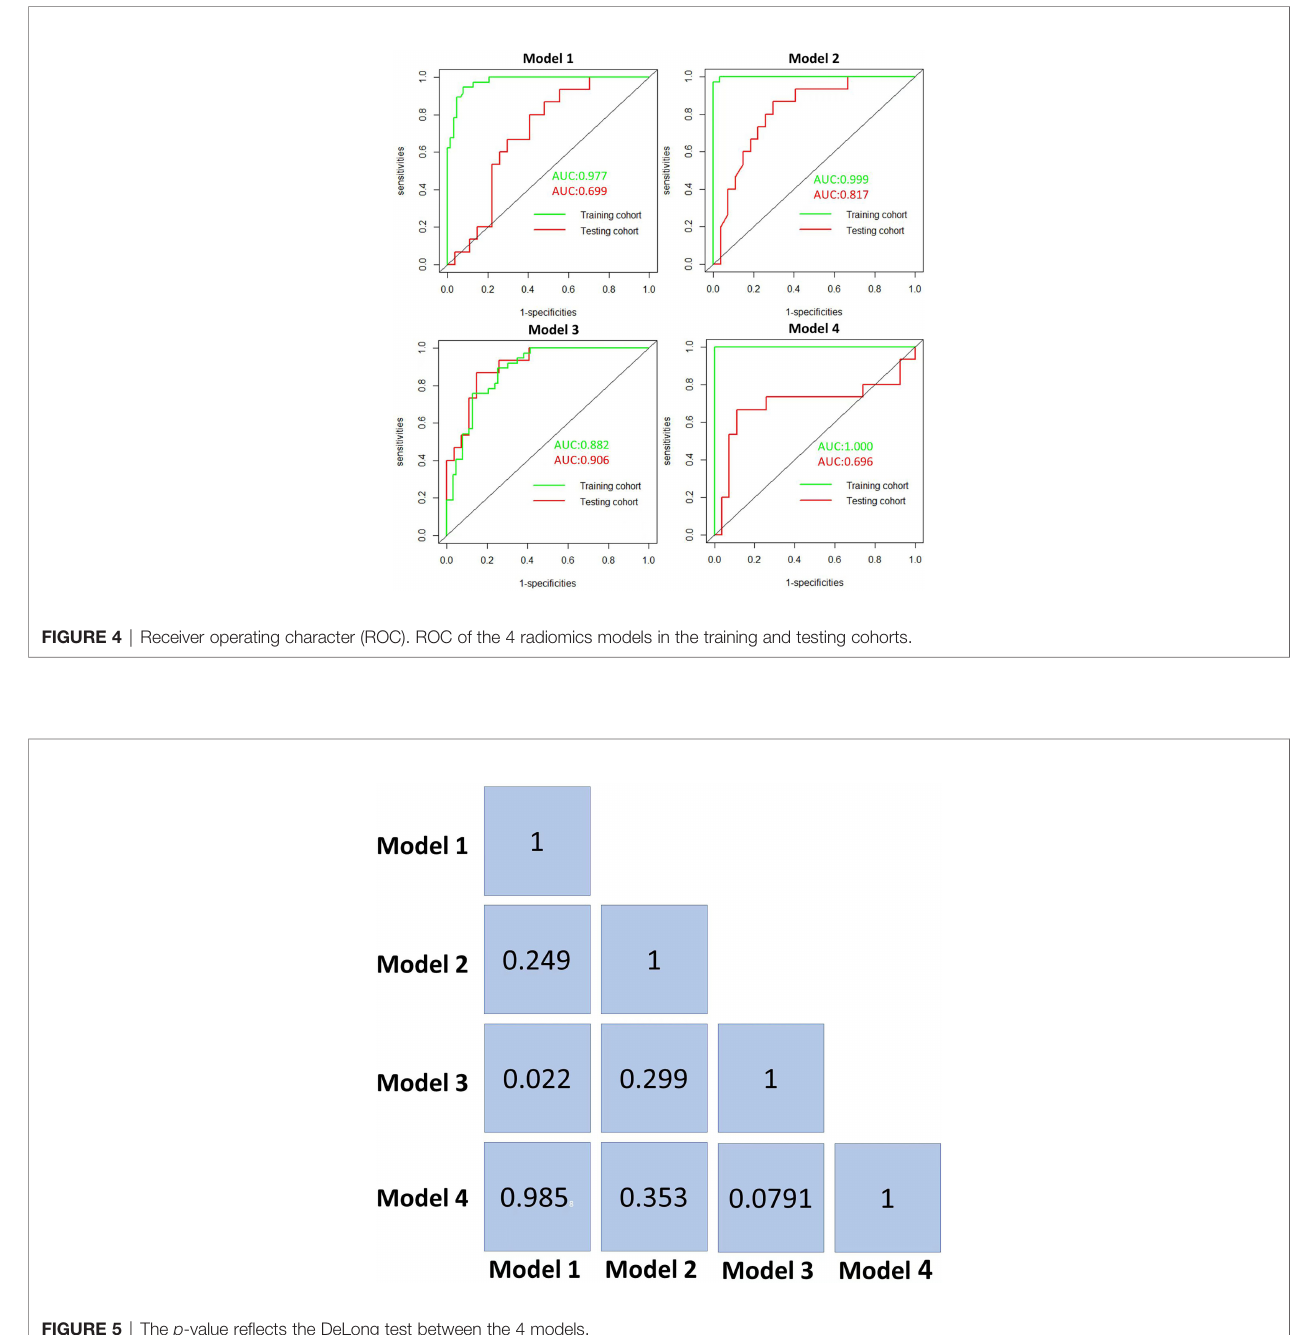
FIGURE 5 | The p -value re fl ects the DeLong test between the 4